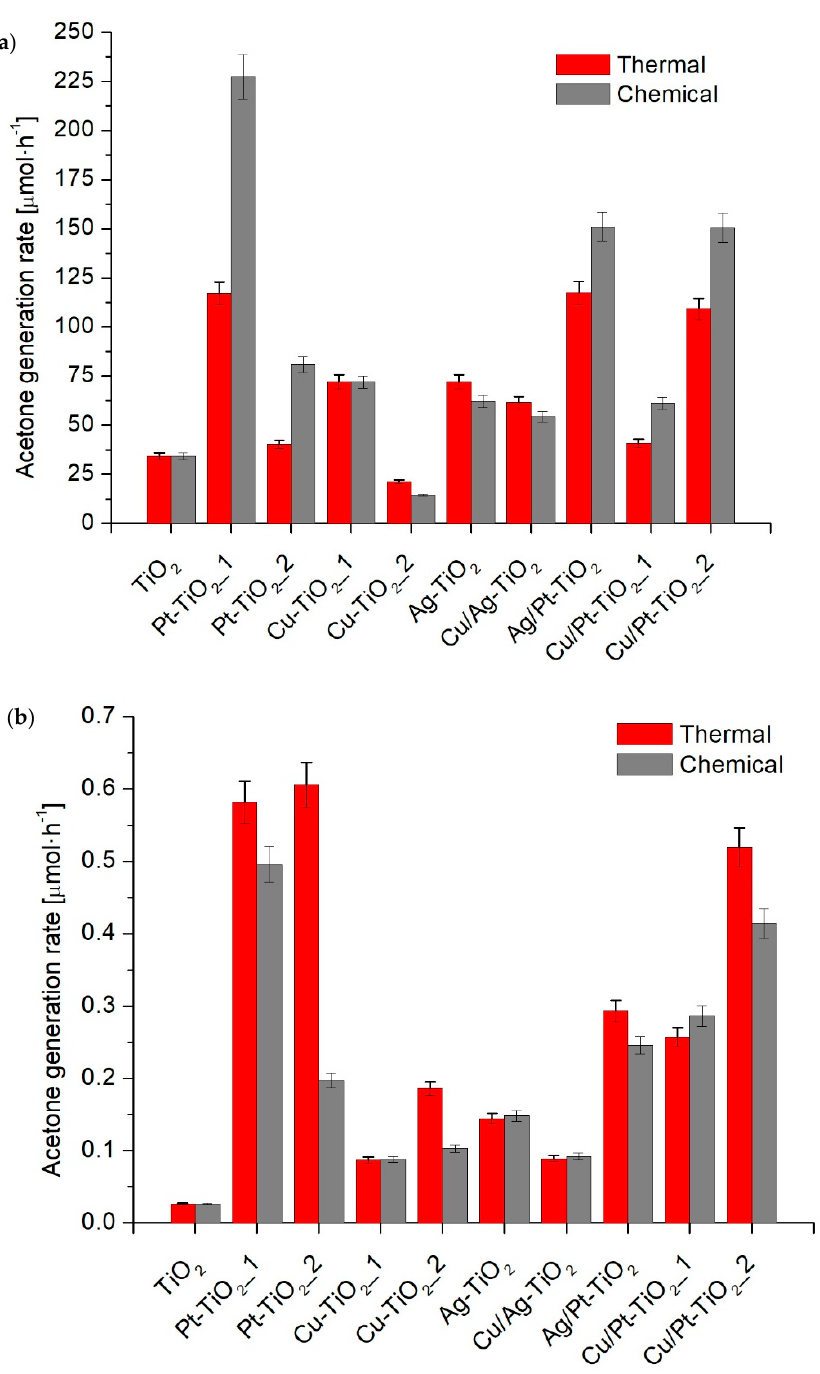
Figure 5. Photocatalytic activity in 2-propanol oxidation under ( a ) UV-Vis and ( b ) Vis.